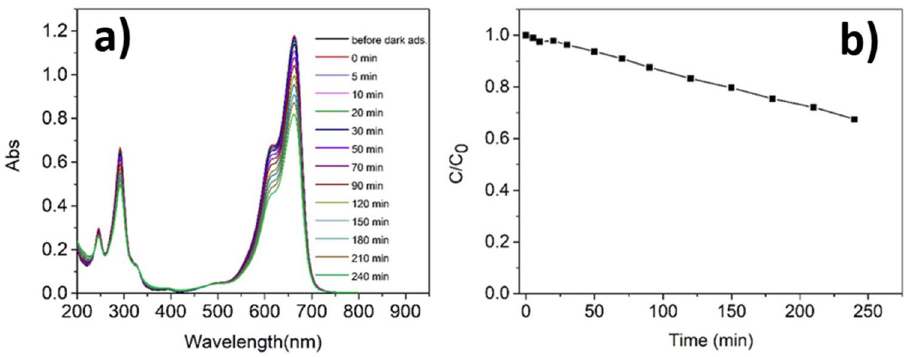
Figure 3. Photo-degradation of an aqueous solution of MB 1.8 × 10 –5 M in the presence of sample 3-UC, namely TiO 2 /NaYF 4 : Yb 3+ (20%), Gd 3+ (2%), Tm 3+ (0.5%) under visible light irradiation: ( a ) variation of the UV– Vis absorption spectra of the MB solution in time during the photodegradation (the first spectrum represents the spectrum acquired before the 30 min of dark adsorption and the zero time is exactly at 30 min after dark adsorption); ( b ) Variation of the concentration of MB in time during the photodegradation.